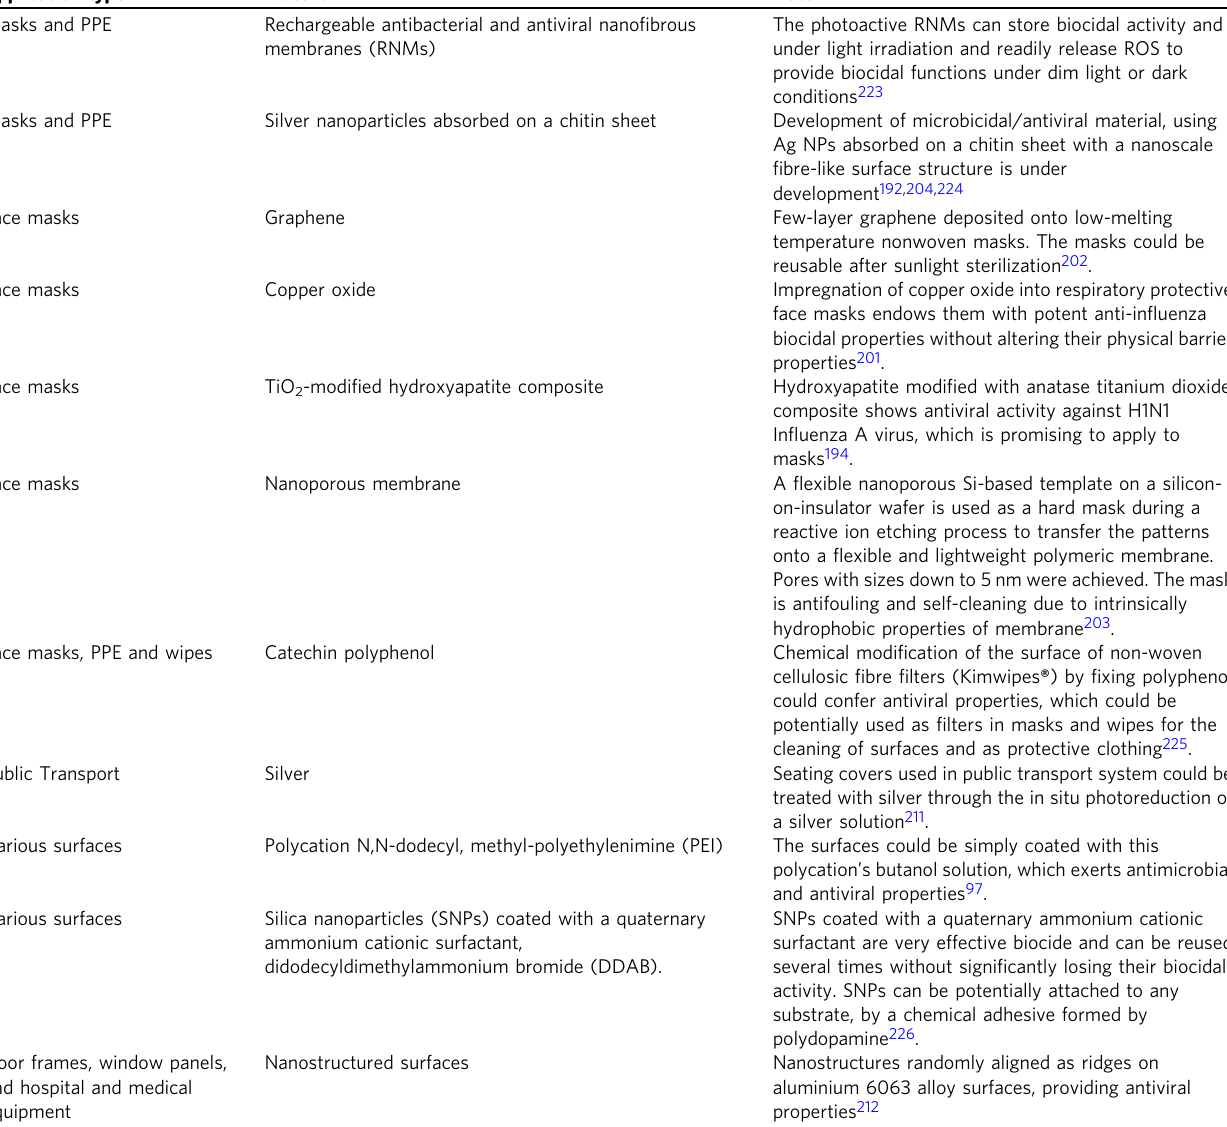
Table 4 Examples of published antiviral materials and coatings with the potential use in PPE, public areas and other